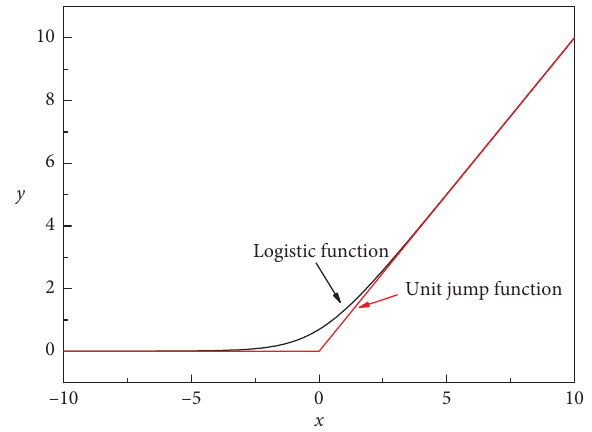
Figure 3: Function diagram comparison